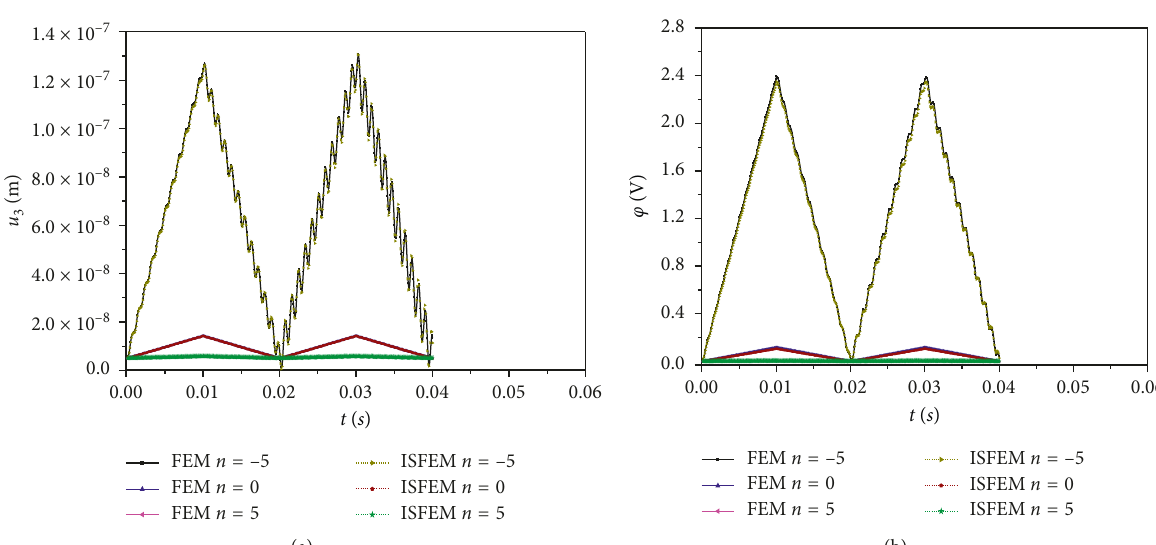
Figure 15: Variations of displacement u 3 and electrical potential φ at the loading point with time of the FGPM beam based on PZT-4 when the gradient parameter was n � − 5, 0, and 5 under triangular load. (a) Displacement. (b) Electrical